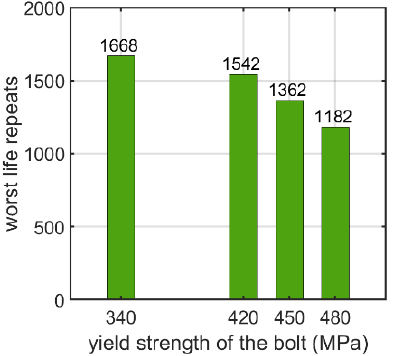
Figure 18. Number of logarithmic life repeats for parameterizing the yield stress of the nutless bolt.